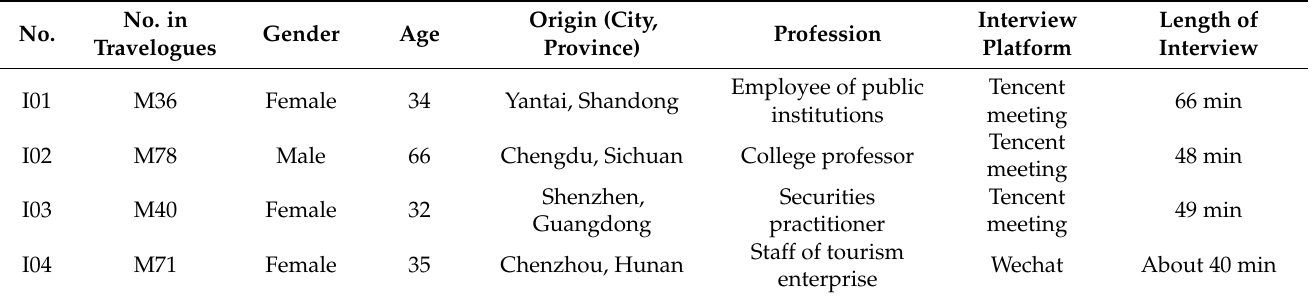
Table A2. Profiles of Informants interviewed